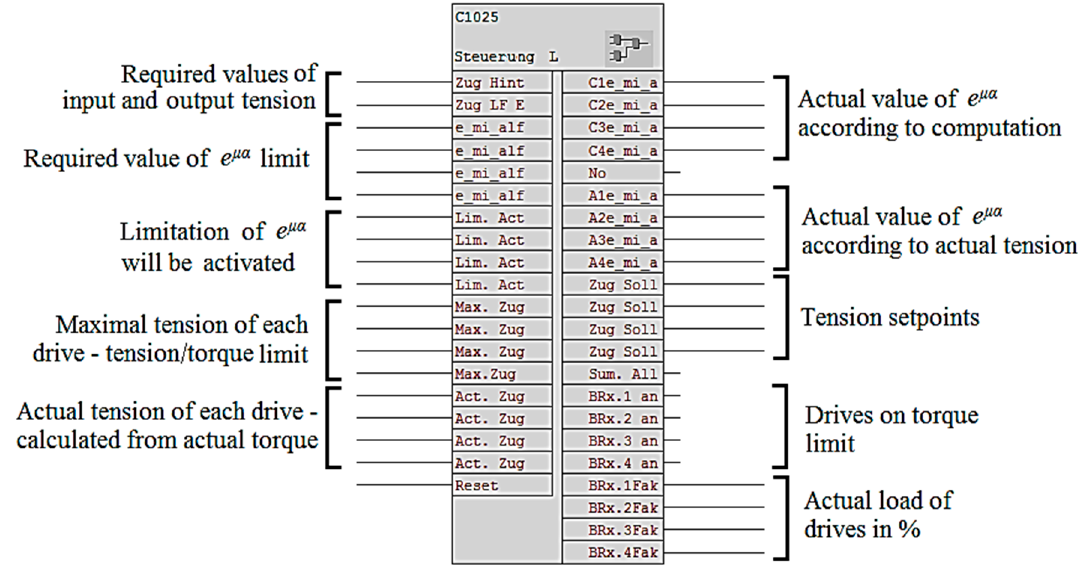
Figure 6. Implementation of the tension distribution algorithm in the CFC programming language.